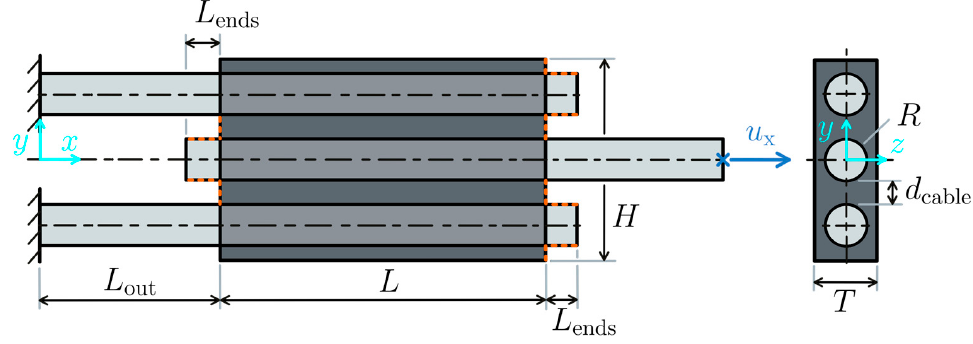
Figure 5. The geometry of the three ‐ cable specimen. Contact is defined in the orange ‐ dashed re ‐